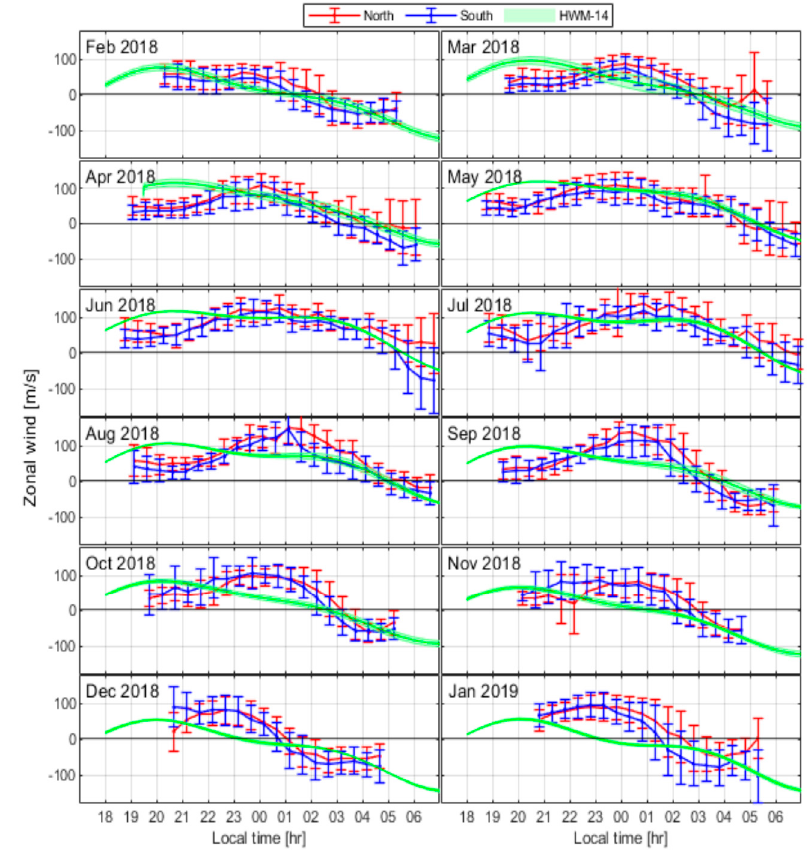
Figure 6. Zonal winds in South Africa for February 2018 to January 2019. The red and blue plots represent the FPI measurements looking in the North and South directions, respectively, while the green plots represent corresponding HWM-14 predictions. The vertical error bars indicate the standard deviations of the observations. Adapted with permission from Ref. [13]. 2022, Ojo et al.